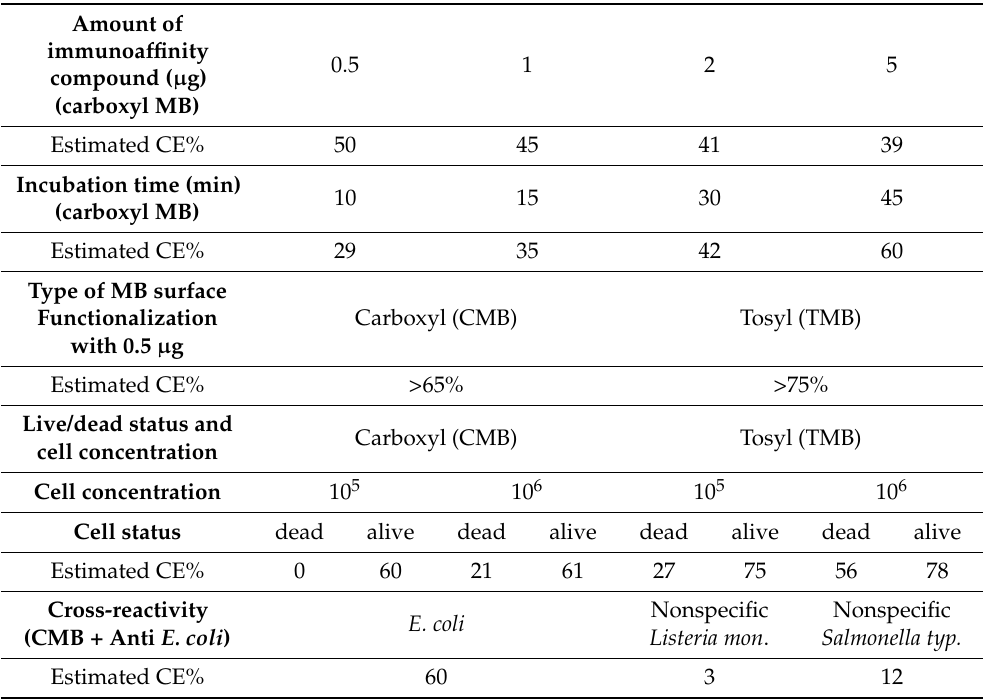
Table 2. Summary of optimization